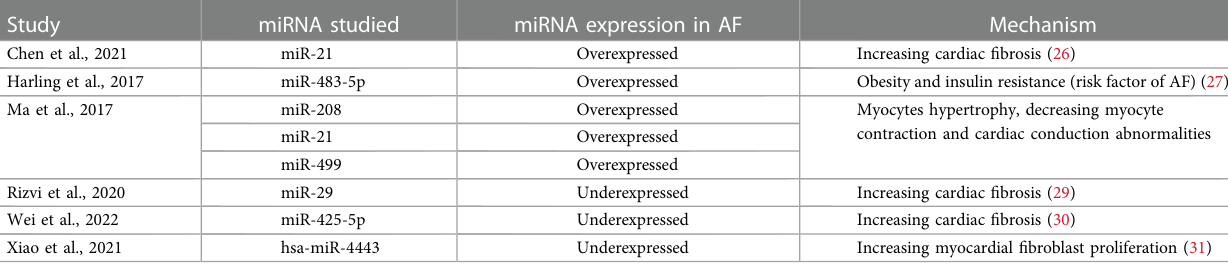
TABLE 2 Type of MiRNAs and its possible mechanism of Developing AF.